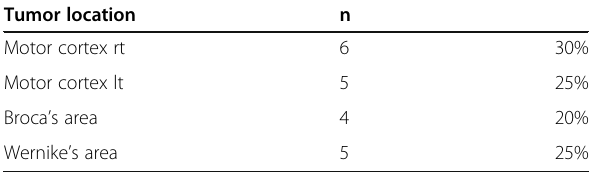
Table 2 Relation of the tumor to eloquent